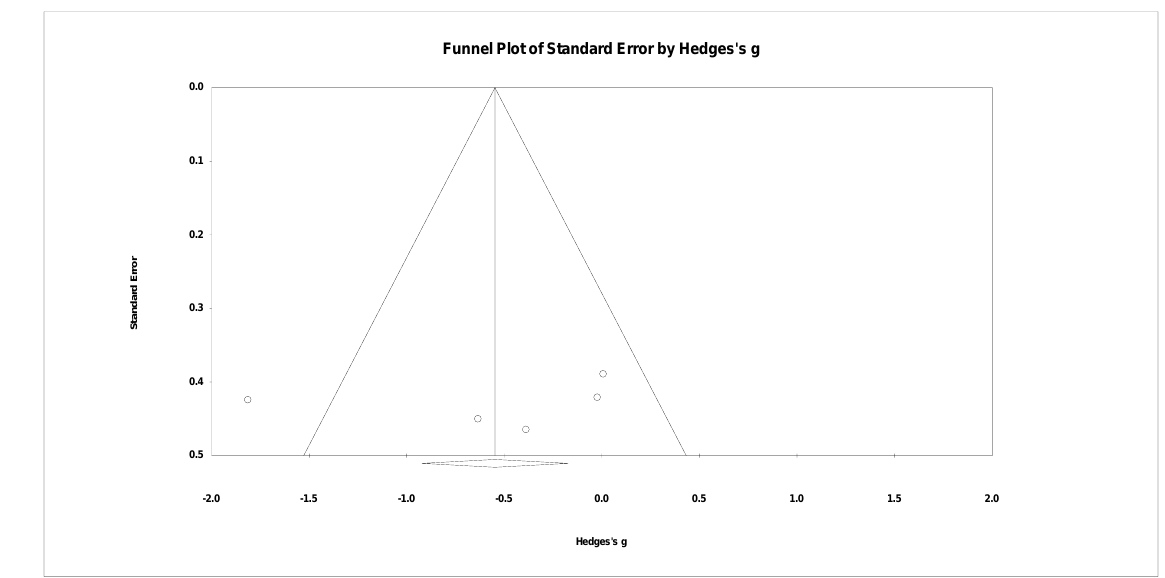
Figure 8. Funnel plot for meta-analysis of the effect of neuro-feedback training on anxiety and depression.